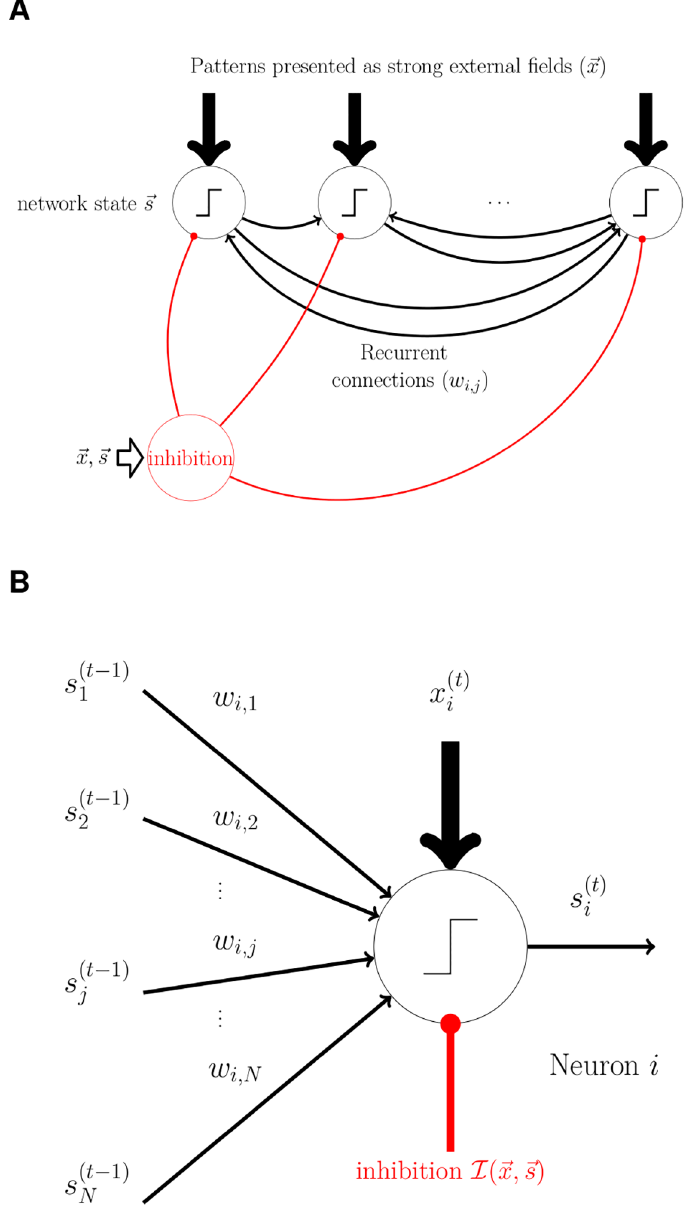
Fig 1. A sketch of the network and the neuron model. A. Structure of the network. The fully-connected network consists of N binary ( s i 2 {0,1}) neurons and an aggregated inhibitory unit. The global inhibition is a function of the state of the network and the external fields, i.e. I ð ~ x ; ~ s Þ . A memory pattern ~ x is encoded as strong external fi elds, i.e. ~ x ¼ X ~ x and presented to the network during the learning phase. B. Each neuron receives excitatory recurrent inputs (thin black arrows) from the other neurons, a global inhibitory input (red connections), and a strong binary external fi eld ( x i 2 {0, X }; thick black arrows). All these inputs are summed to obtain the total fi eld, which is then compared to a neuronal threshold θ ; the output of the neuron is a step function of the result.